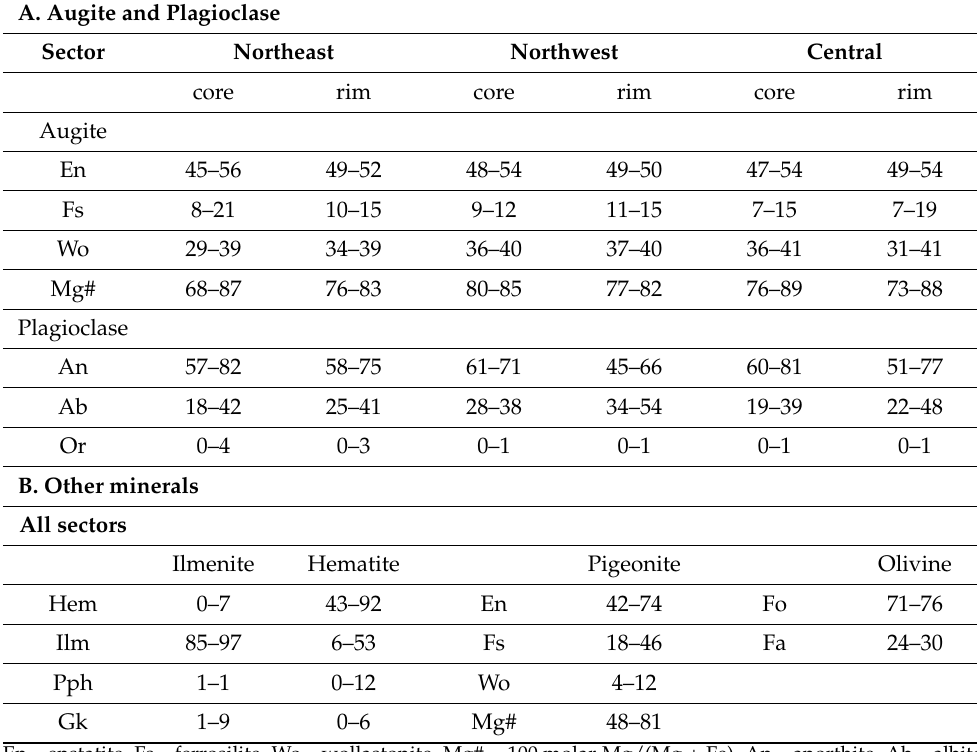
Table 2. Composition range of minerals in the Rajmahal basalts.